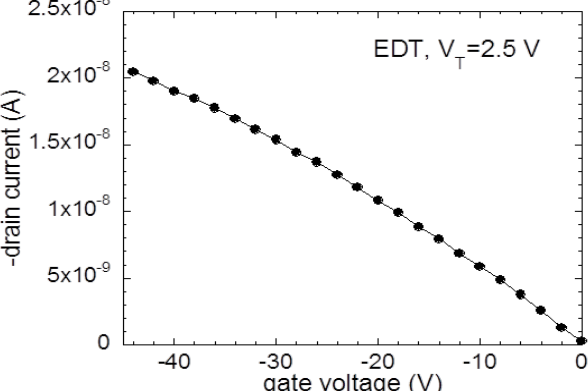
Figure 5. Transfer characteristic curve for a PbSe FET treated with 1,2-ethanedithiol (EDT). The drain voltage was fixed at − 5 V. The channel length and width are 80 µ m and 2 mm, respectively. The PbSe QD film thickness ranges between ~50 and ~80